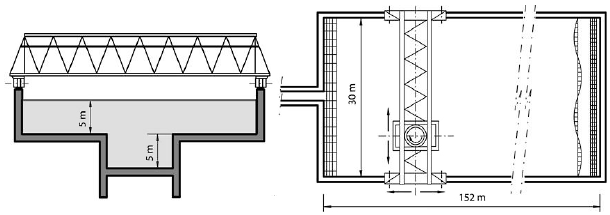
Fig. 2. Layout of the CEHIPAR wave basin.